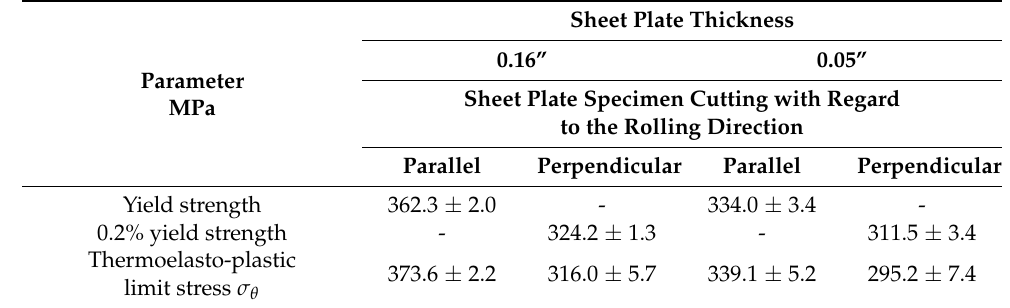
Table 9. A summary of the yield strength and the thermoelasto-plastic limit stress values for sheet plates made of the 2024-T3 aluminum alloy depending on the thickness and the rolling direction.